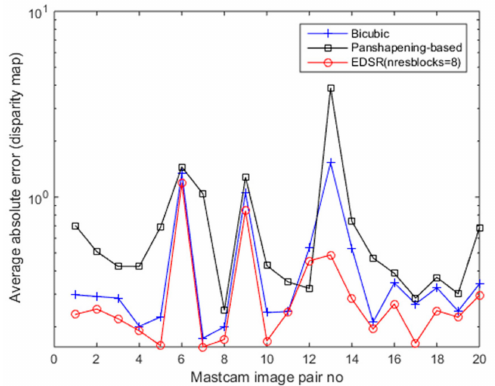
Figure 20. Average absolute errors for 20 Mastcam image